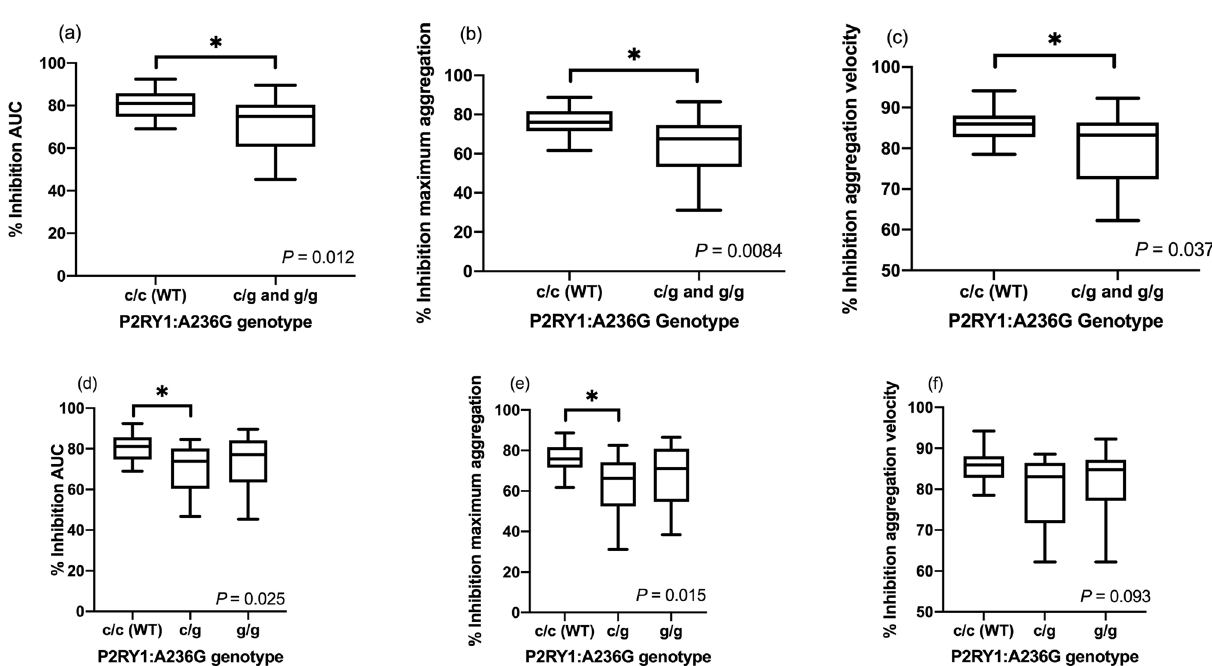
Figure 4. The percent inhibition of ( a ) area under the curve (AUC), ( b ) maximum aggregation (AU), and ( c ) aggregation velocity, measured by whole blood aggregometry, in cats with P2RY1:A236G wildtype (WT) (c/c) and variant genotype (both c/g and g/g genotypes). The percent inhibition of ( d ) AUC, ( e ) AU, and ( f ) aggregation velocity were further divided into wildtype (c/c), heterozygous (c/g), and homozygous (g/g) genotypes. The horizontal line represents the median, the box the 25th and 75th percentile, the whiskers the 1.5 times interquartile range, and the points outside the whiskers are